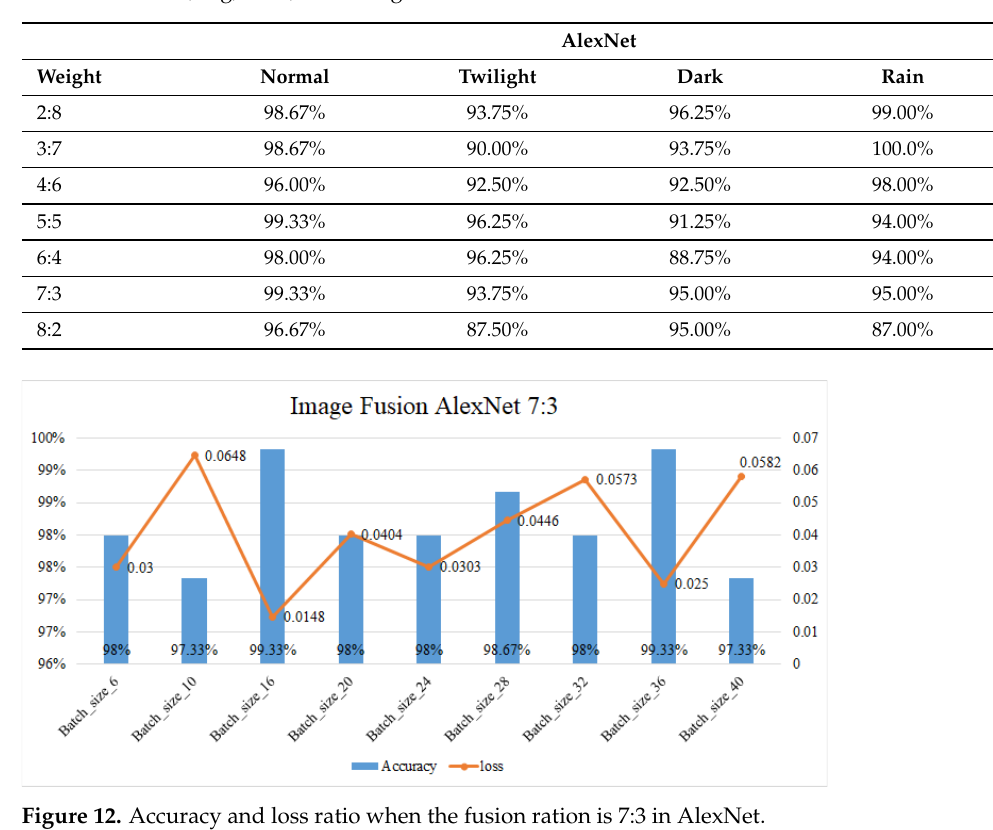
Table 4. The rain, fog, dark, and twilight bad weather conditions in Alexnet fusion ratio.